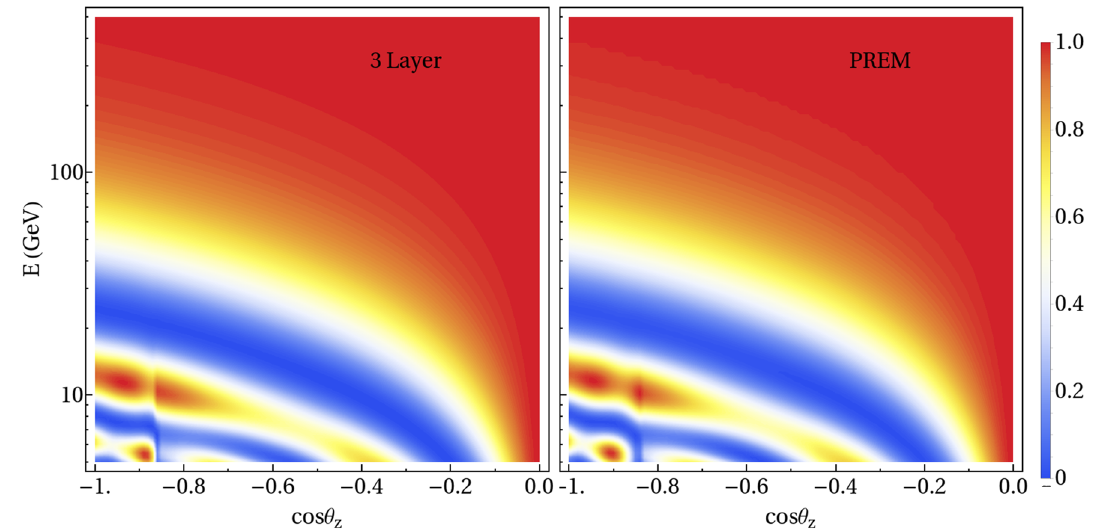
Fig. 7 Oscillograms for P μμ without decoherence, considering our three-layer approximation (left panel) and the PREM model (right panel) for the Earth matter density profile